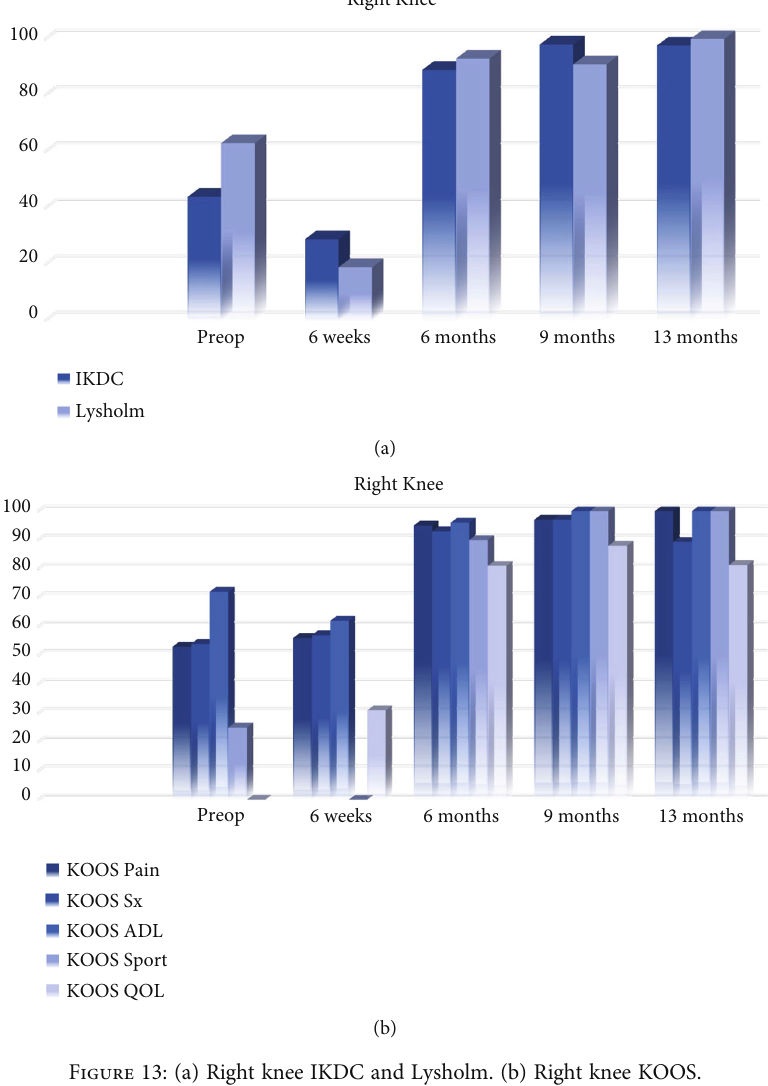
Figure 13: (a) Right knee IKDC and Lysholm. (b) Right knee KOOS.